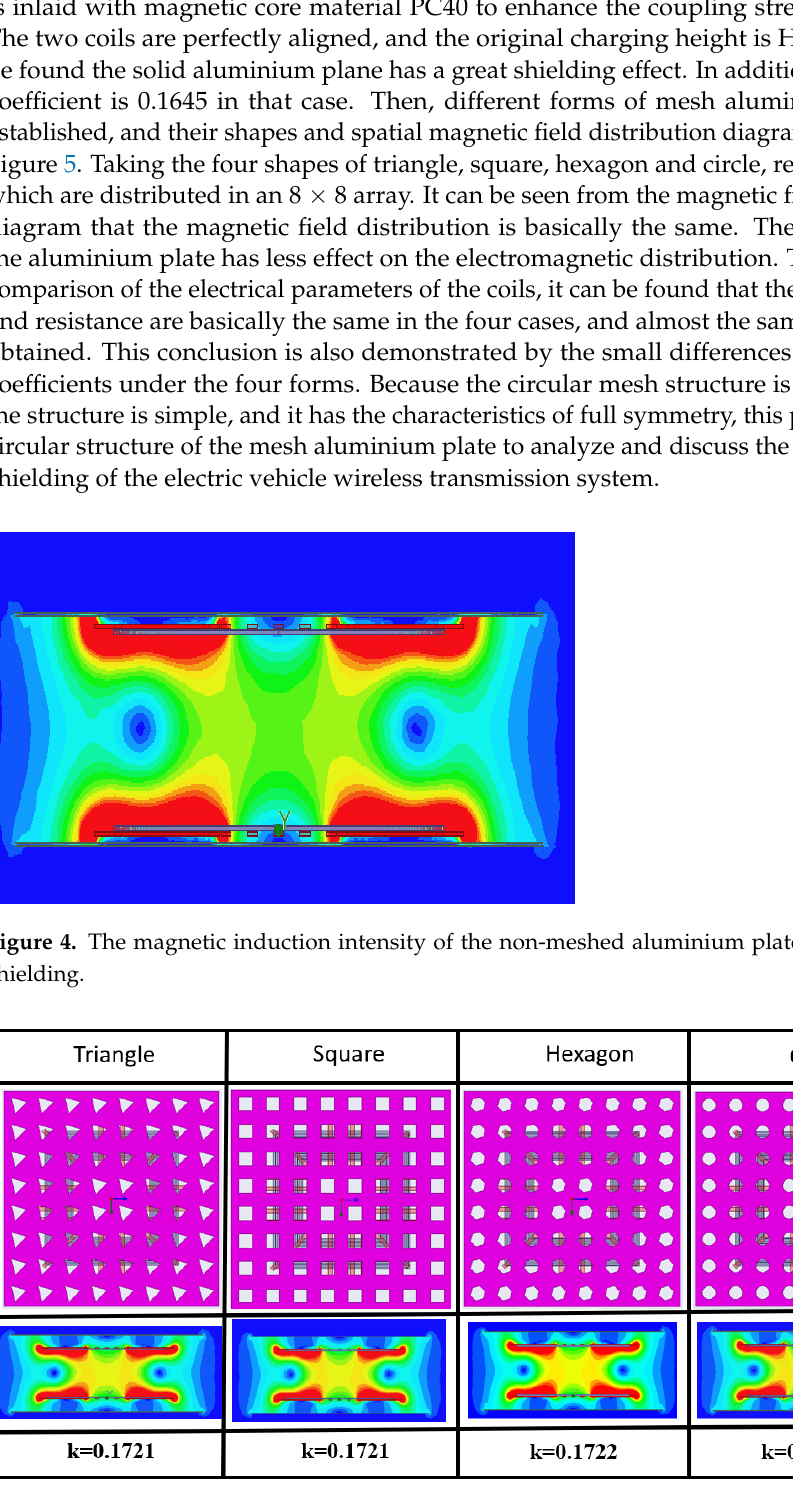
( d ) Figure 6. Magnetic field distribution of aluminium plate with different mesh array structure: ( a ) solid aluminium plate; ( b ) 4 × 4; ( c ) 8 × 8; ( d ) 16 × 16. 3.2. Effect of Mesh Aluminium Plate Size on System Firstly, the influence of different sizes of mesh aluminium plates is analysed. The schematic diagram of the structure is shown in Figure 7. It is assumed that the thickness of the mesh aluminium plate is t = 2 mm and the distance from the coil is d = 50 mm. Assuming that the coupling coils are all in a resonance state, when the size of the alumin- ium plate S increases from 50 cm to 100 cm, the changing relationship of the self-induction, resistance, coupling coefficient and transmission efficiency of the coupling coil is shown in Figure 8. k represents the coupling coefficient between the coils (the ratio of the mutual inductance between two coils to the product of their self-inductance). It can be seen from the figure that with the increase of the size of the aluminium plate, the influences of the transmitting coil and receiving coil of the reticulated aluminium plate with different array structures tend to be the same, that is, the inductance shows a downward trend, while the